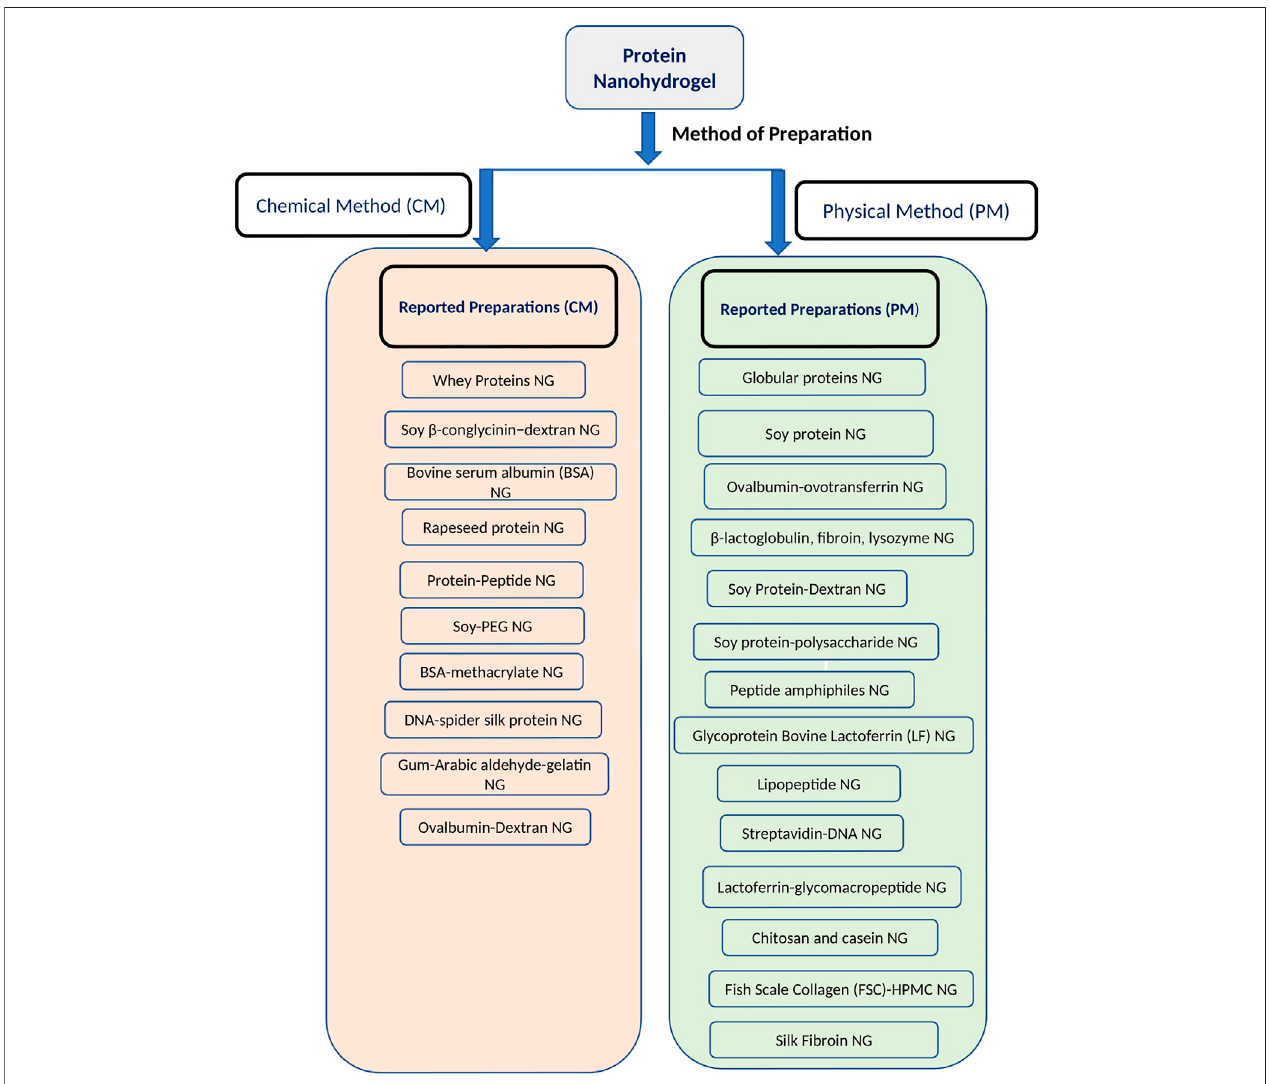
FIGURE 2 | Reported protein nanohydrogels for bioactive delivery based upon methods of preparation.